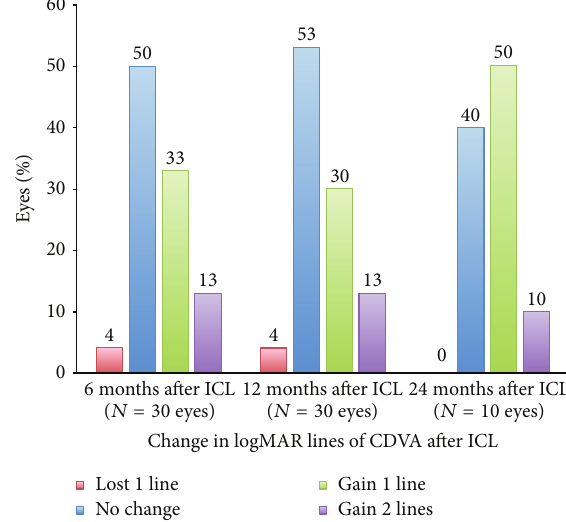
Figure 1: Change in corrected distance visual acuity (CDVA) following toric implantable collamer lens implantation